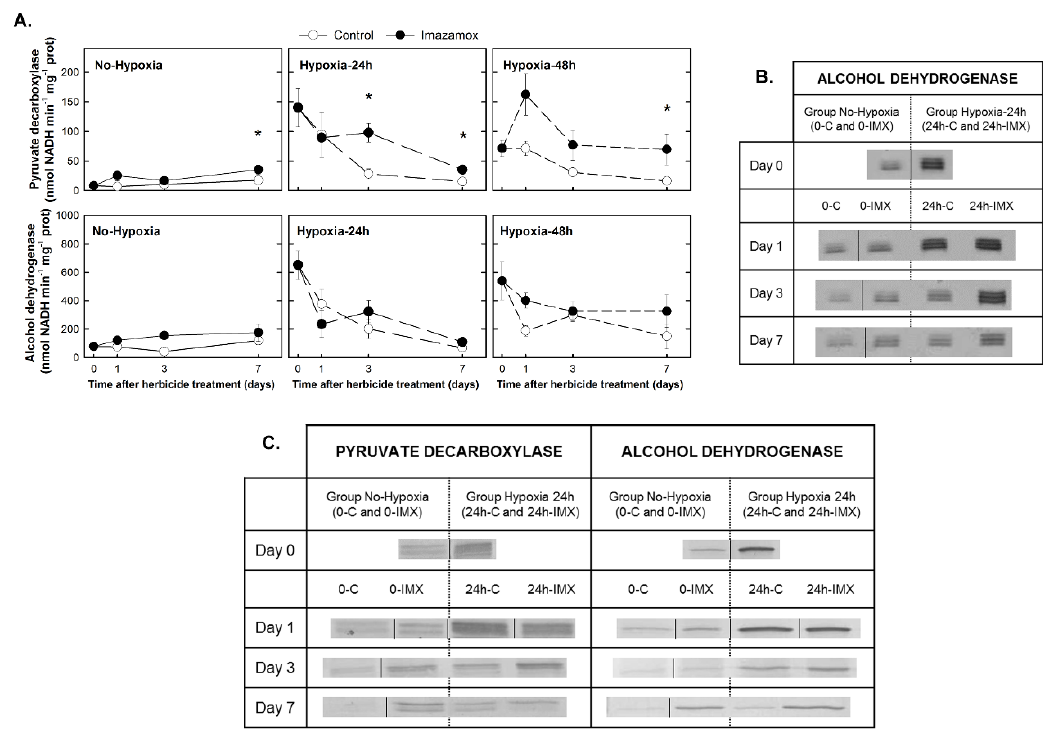
Figure 2. Pyruvate decarboxylase (PDC) and alcohol dehydrogenase (ADH) in the roots of pea plants. Pea plants were not treated with hypoxia before herbicide application (the No-Hypoxia group) or were treated with hypoxia for 24 h or 48 h before herbicide application (the Hypoxia-24h and Hypoxia-48h groups). Half of the plants from each group were treated with imazamox (5 mg L − 1 , black symbols). The others were not treated with herbicide and were used as controls (white symbols). The di ff erent treatments were named with a combination of two codes: the first code refers to the hours of hypoxia (0, 24 h, or 48 h), and the second one indicates if plants were treated with imazamox (IMX) or were controls (C): 0-C, 0-IMX, 24h-C, 24h-IMX, 48h-C, 48h-IMX. ( A ) In vitro activities of PDC and ADH in the roots of pea plants. Values represent the mean ± SE ( n = 4 biological replicates). Significant variations are marked with * for di ff erences between control and imazamox-treated plants ( t -Test, p < 0.05) on a given day. See Supporting Information Table S1 for the two-way ANOVA results. ( B ) Native PAGE for ADH activity in pea roots. Each lane contained 1.75 µ g of protein. ( C ) Immunoblot detection of PDC and ADH on days 0, 1, 3, and 7 after imazamox application. Each lane contained 30 µ g of protein. In blots and gels, each vertical dividing line indicates lane or lanes removed from the original image. See supporting Information Figures S1, S2 and S3 for full gel images.